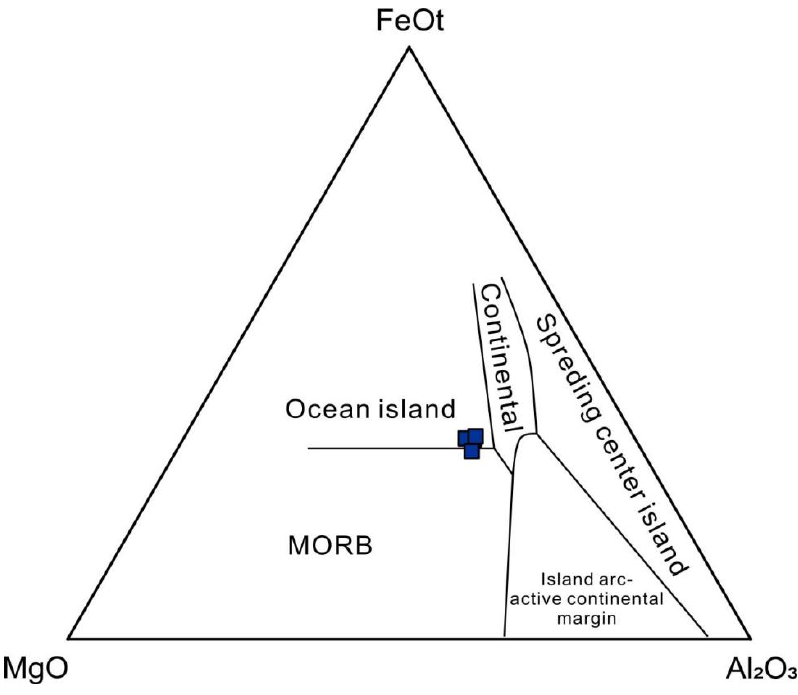
Figure 17. MgO-FeO t -Al 2 O 3 diagram [52] of Liwanxincun metabasalt.